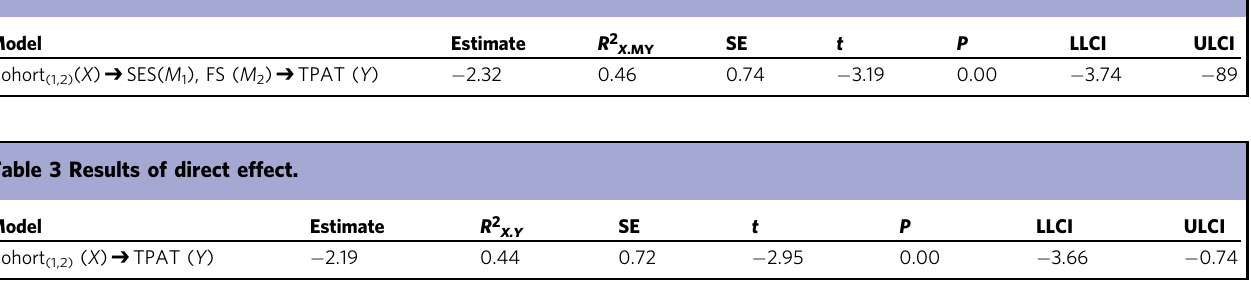
Table 2 Total effect of the model.